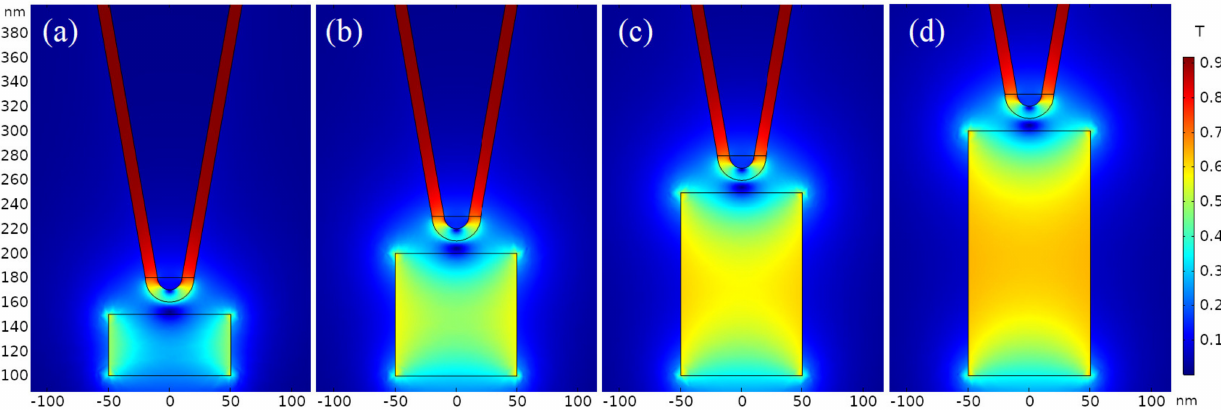
Figure 7. Magnetic flux density distribution detected by the probe of H = 1 µ m, θ = 10 ◦ , R = 10 nm, t = 10 nm, α = 0 ◦ for ferromagnetic single-domains with a diameter of 100 nm and a thicknesses of ( a ) 50 nm; ( b ) 100 nm; ( c ) 150 nm; and ( d ) 200